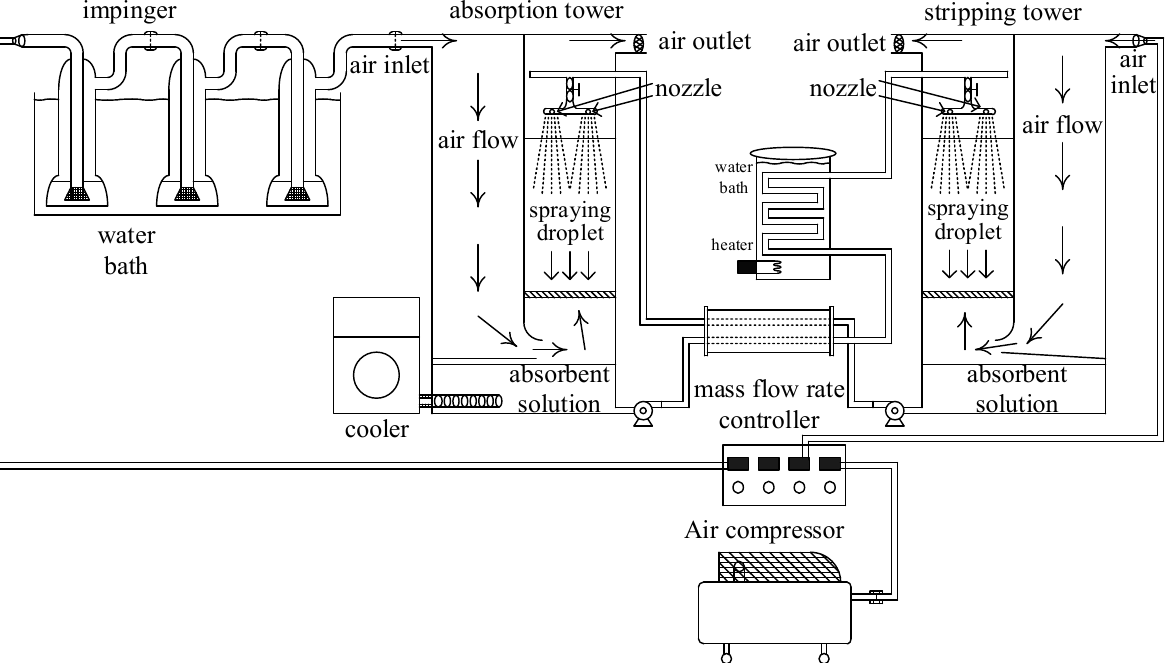
Figure 2. Spray-bed absorber in this study.